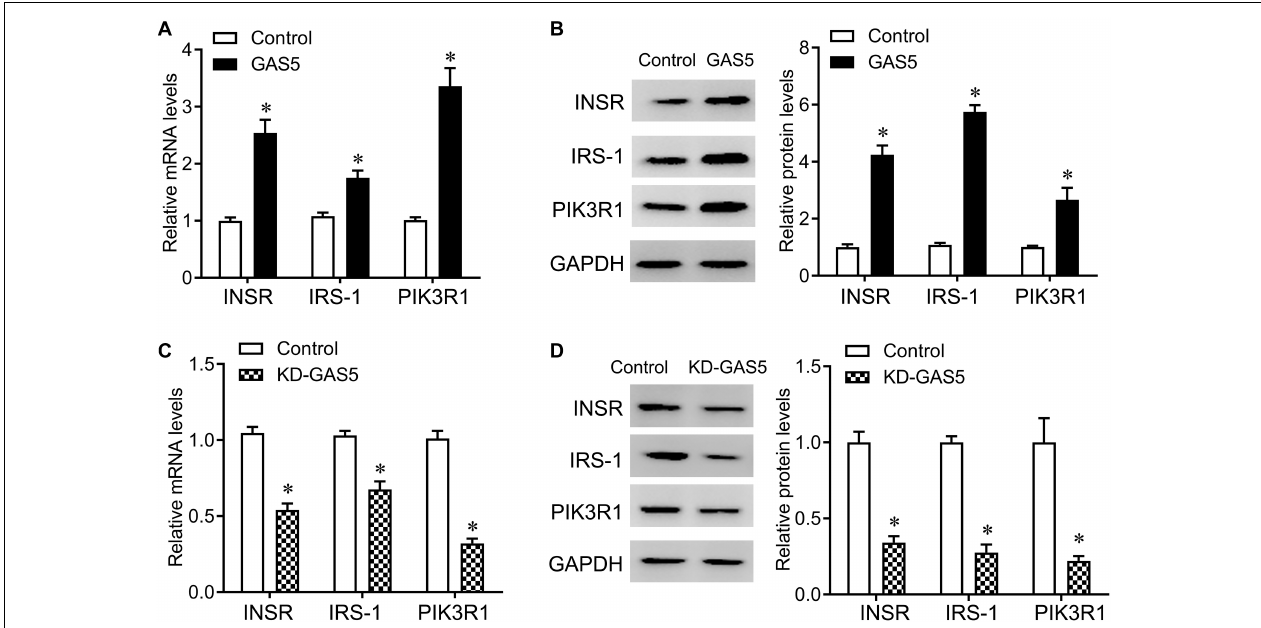
FIGURE 5 | GAS5 positively regulates the expression of INSR, IRS-1 and PIK3R1. (A,B) QPCR (A) and Western blot (B) were performed to determine the mRNA and protein levels of INSR, IRS-1 and PIK3R1 in INS-1 832/13 cells after transfection with lentivirus carrying GAS5 DNA sequence or empty pReceiver-Lv218 vector control. (C,D) QPCR (C) and Western blot (D) were performed to determine the mRNA and protein levels of INSR, IRS-1 and PIK3R1 in INS-1 832/13 cells after transfection with lentivirus carrying GAS5 shRNA sequence or scramble control. The expression was normalized to control. Data were presented as mean ± SD. * p < 0.05 vs. control. KD,